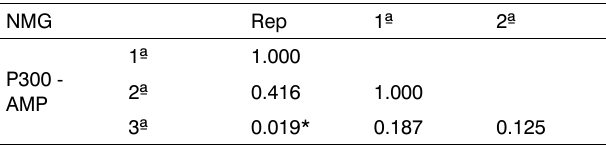
Table 2. Comparison of p-values at testing moments for the amplitude in the